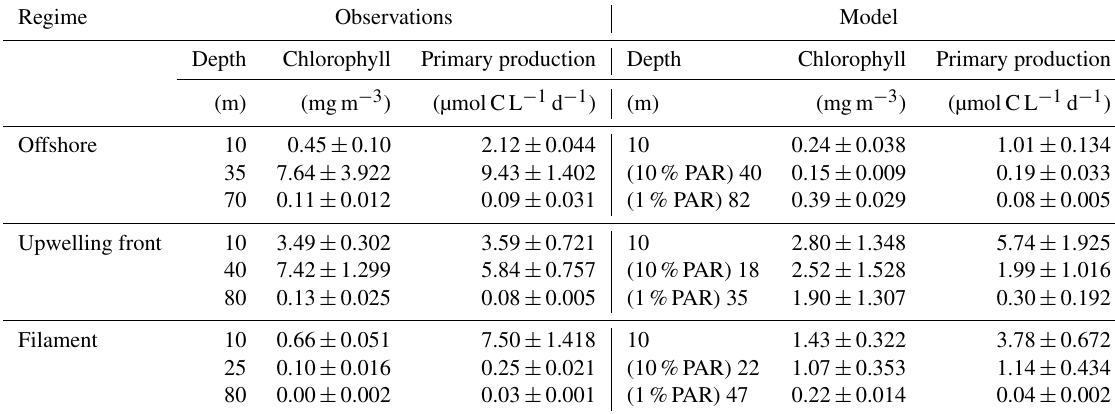
Table 1. Observed and modeled primary production for different dynamical regimes, each at three different depths. The first sample was always taken at 10m, while the remaining two were placed in the chlorophyll maximum below the mixed layer (25–40m, ∼ 10% surface PAR) and a chlorophyll minimum below the euphotic zone (70–80m, ∼ 1% surface PAR). Sampling sites and the corresponding model locations used for comparison are marked with letters O, U, and F in Fig. 3c, d. Standard deviation represents triplicate samples for the PP observations, ± 3m bottle depth for the corresponding chlorophyll fluorescence profiles, and differences between individual grid points for the model